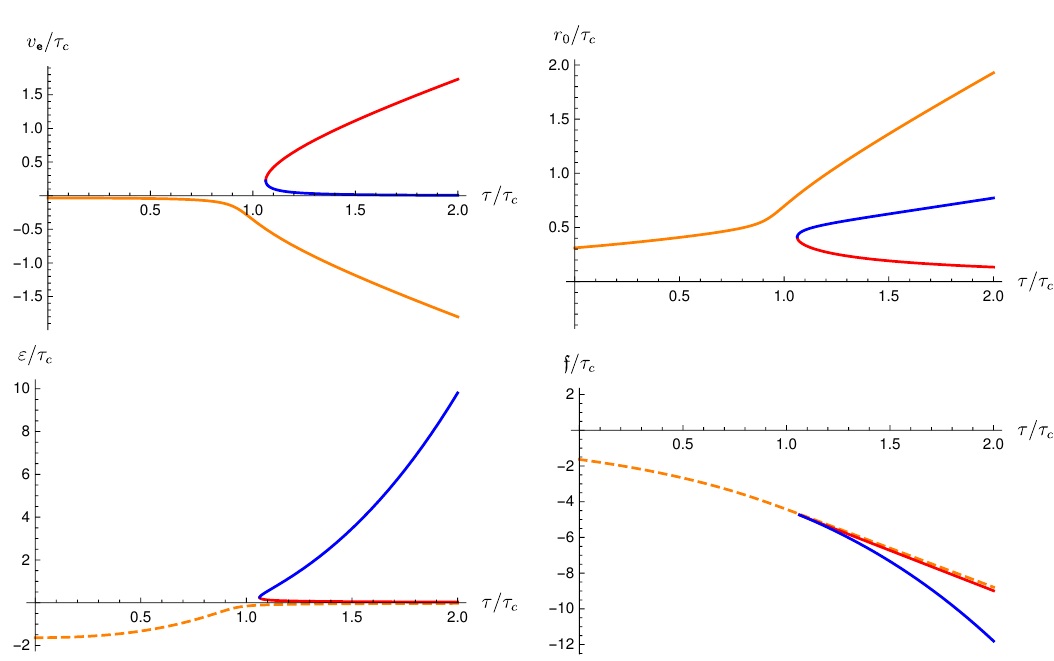
Figure 3 . Plot of the solutions of (6.24) for (cid:26) = 0 : 314 (cid:26) c , together with the corresponding energy " and Helmholtz free energy f densities.